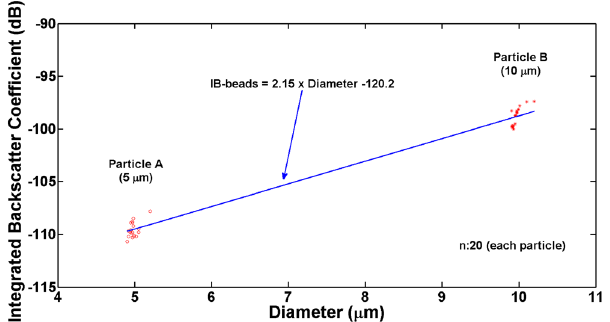
Figure 3. Measured integrated backscattering coefficients of trapped microspheres with sizes 5 and 10 μ m in diameter. The number of each sample was 20. The blue solid line indicates the slope of the IB coefficient obtained by linear regression